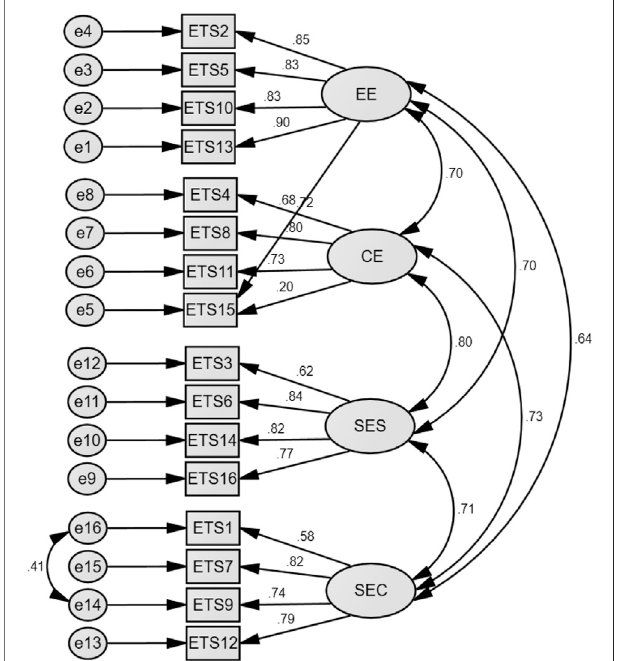
FIGURE 2 | Con fi rmatory factor analysis for the revised model of the C-ETS with modi fi